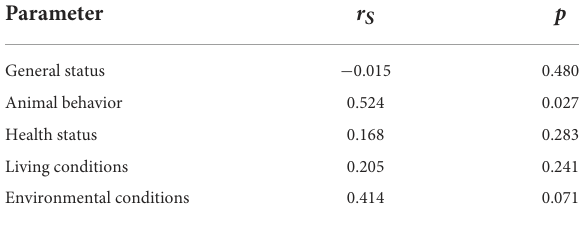
TABLE 4 Spearman’s correlation coefficients between observational and self-assessed importance scores for individual